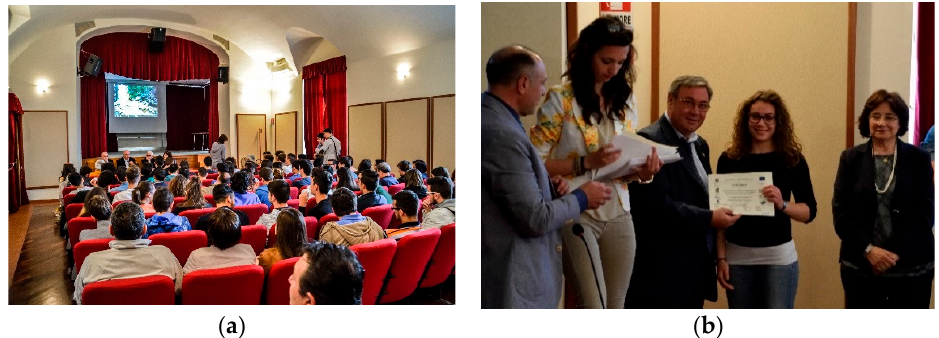
Figure 13. Two moments of the awarding of students at the end of the 2016 course (IS Ae high school headmaster Pr. Mrs. F. De Vizia, Pr. F. Russo and Pr. M. Sisto): ( a ) the hall of the Mirabella Eclano Theater, during the presentation of certificates to the students participating in the PLS; ( b ) a moment of the award ceremony.